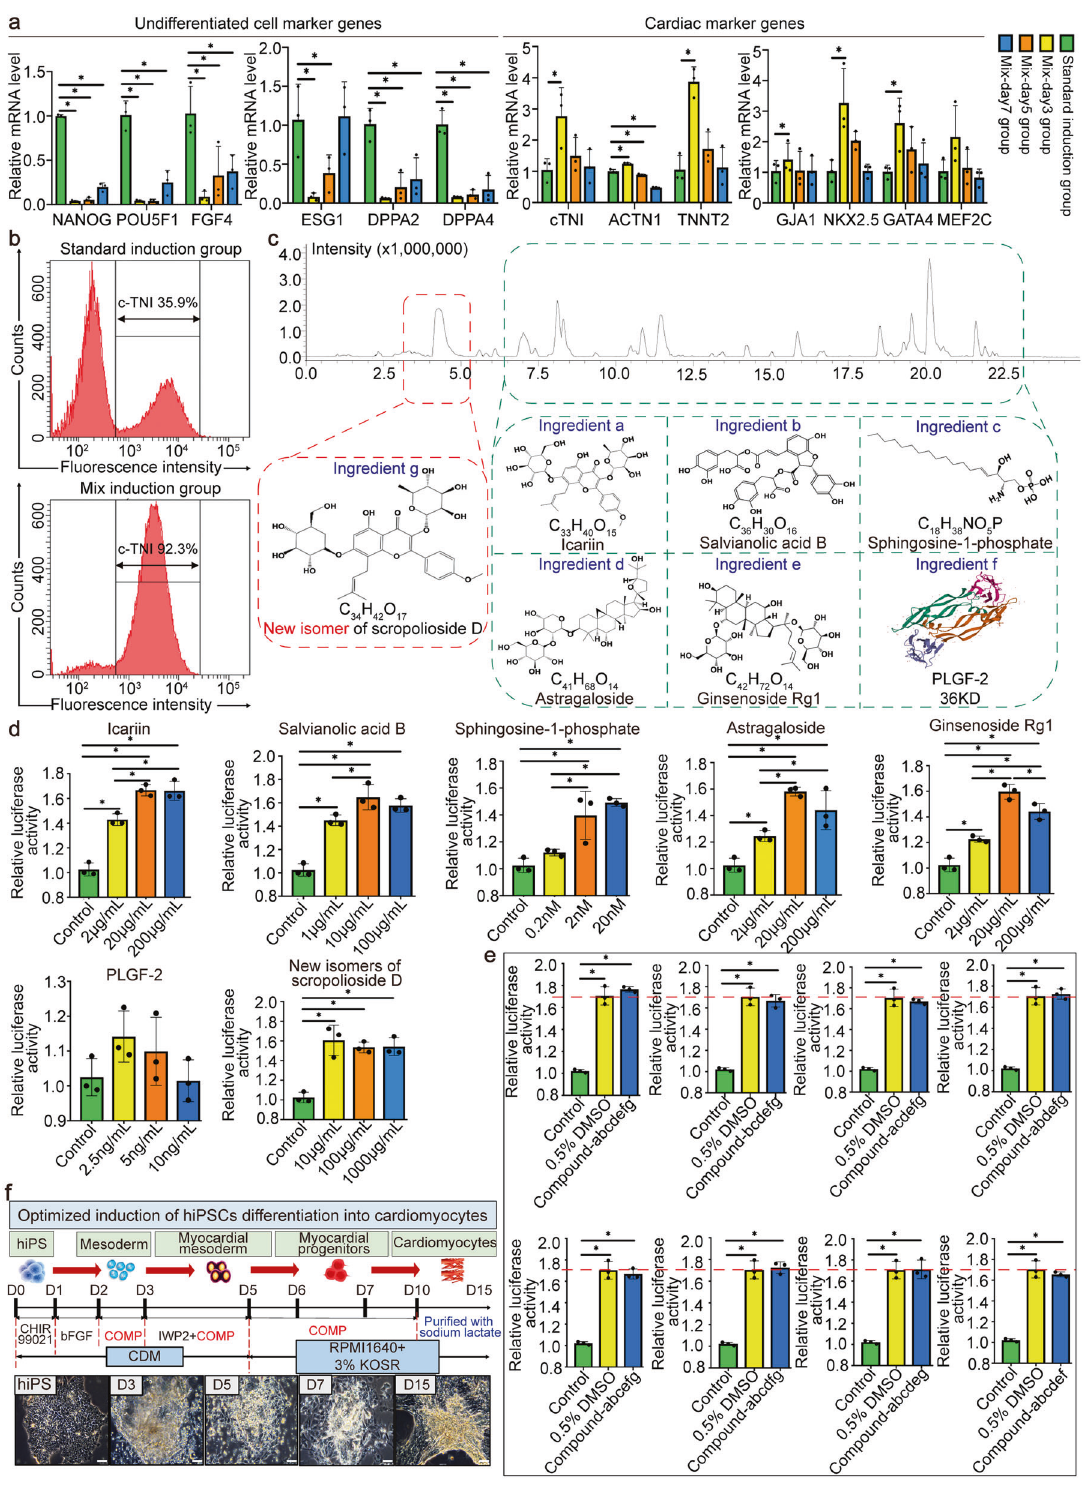
consistently made in fi eld potential, where the compound induction group could response with a stable fi eld potential voltage after ISO/lidocaine stimulation (Fig. 3b). After activation by ISO, the depolarization and repolarization time of the compound induced hiPS-CMs were signi fi cantly shortened and regular in orders, while the standard induced hiPS-CMs showed irregular disorders. After different concentrations of lidocaine